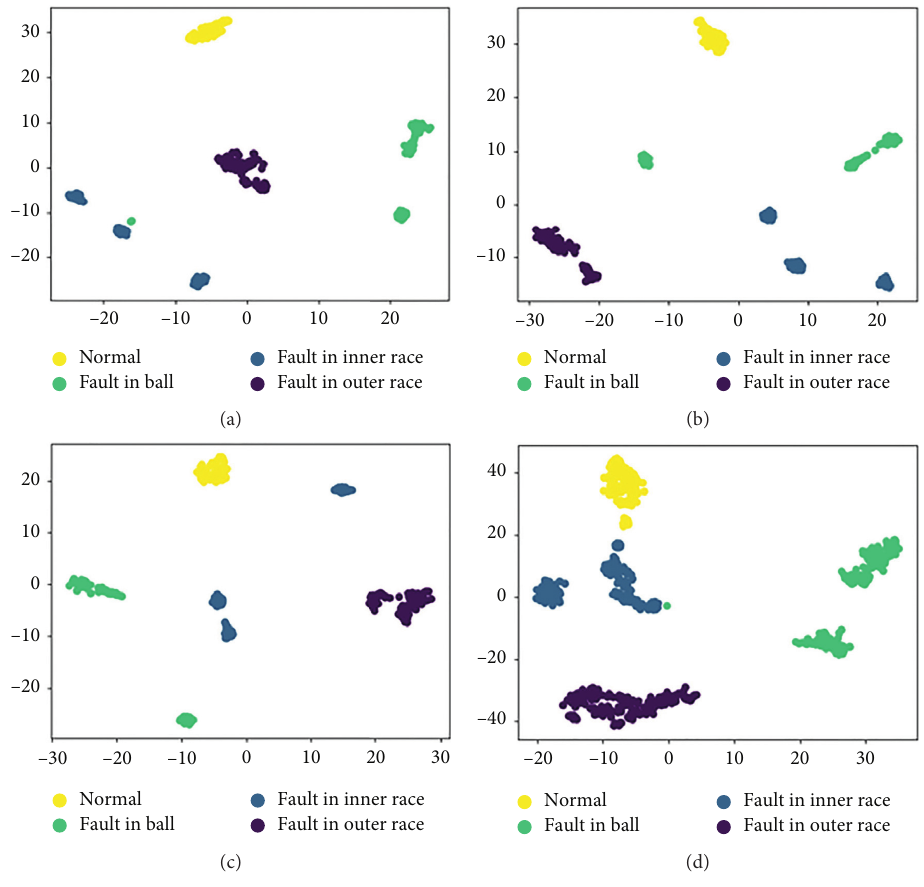
Figure 4: Fully connected layer output visualization of different data sets. (a) Set A. (b) Set B. (c) Set C. (d) Set D. Table 3: Testing results of different weight ratios. Weight ratio Classification accuracy